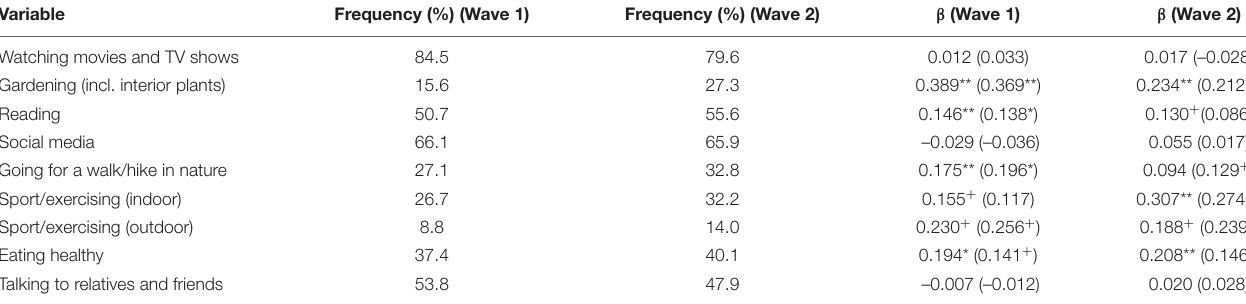
TABLE 8 | Perceived threat and self-nature connection: Descriptive statistics and correlations. Variable M (SD) (Wave 2) Correlation With Self-nature